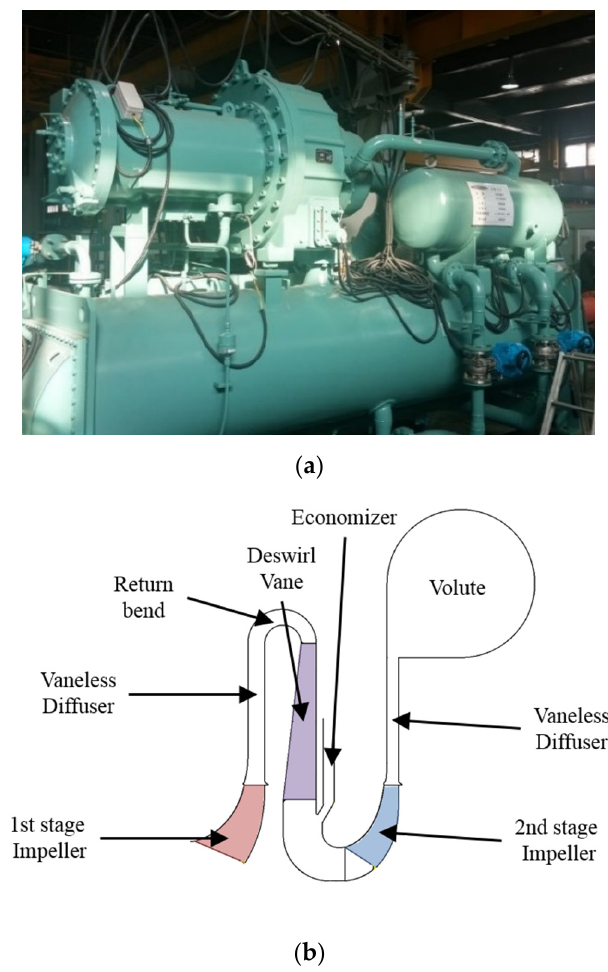
Figure 4. Centrifugal chiller and its drop-in test using low-GWP alternative refrigerants. ( a ) Centrifugal chiller for the drop-in test and ( b ) meridional plane.